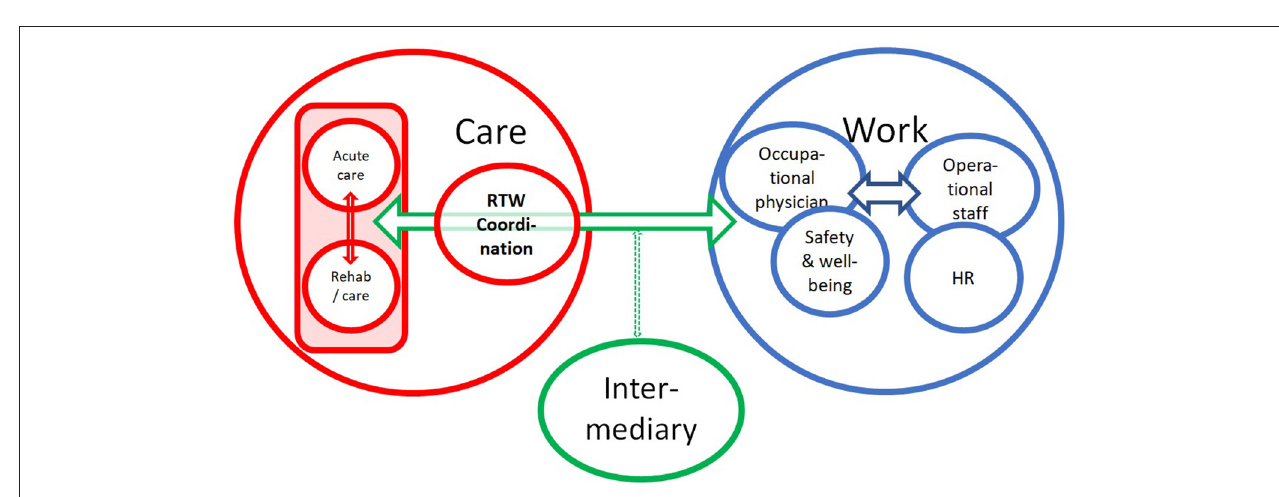
FIGURE 5 | Schematic representation of best practice for the role of hospitals in RTW support for occupationally active cancer